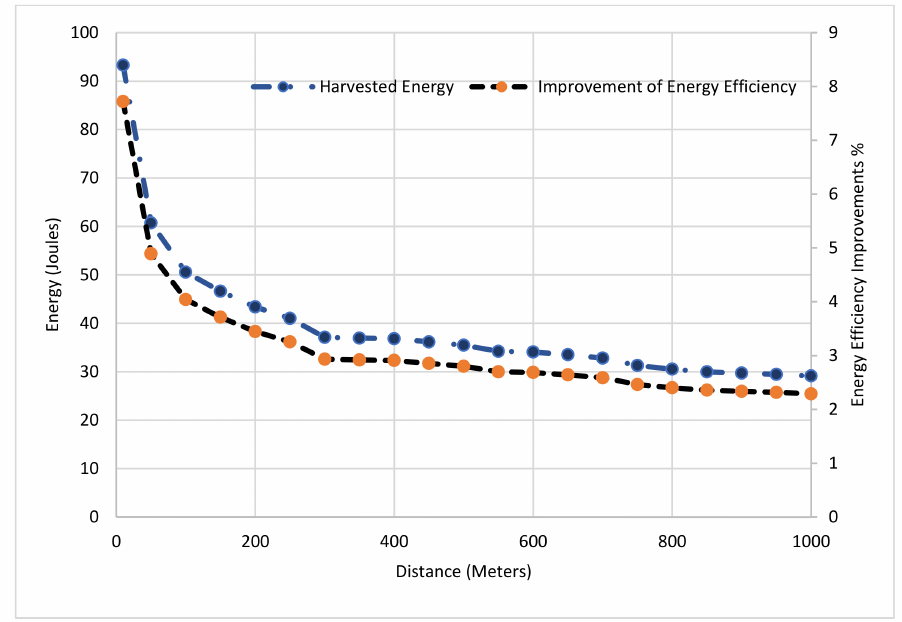
Figure 11. The performance of the TDS-OFDM using TS-SWIPT verses the communication distance, b . The energy harvested improvement for TDS-OFDM can be reached up to 8% in a short communication distance. Figure 12 shows the performance of the TDS-OFDM over the UWA channel at different maximum channel tap delays, as the maximum channel tap delay increases; the improvement of the energy efficiency and the harvested energy both are increased using the proposed energy harvesting scheme where the duration of the symbols used in harvested energy is